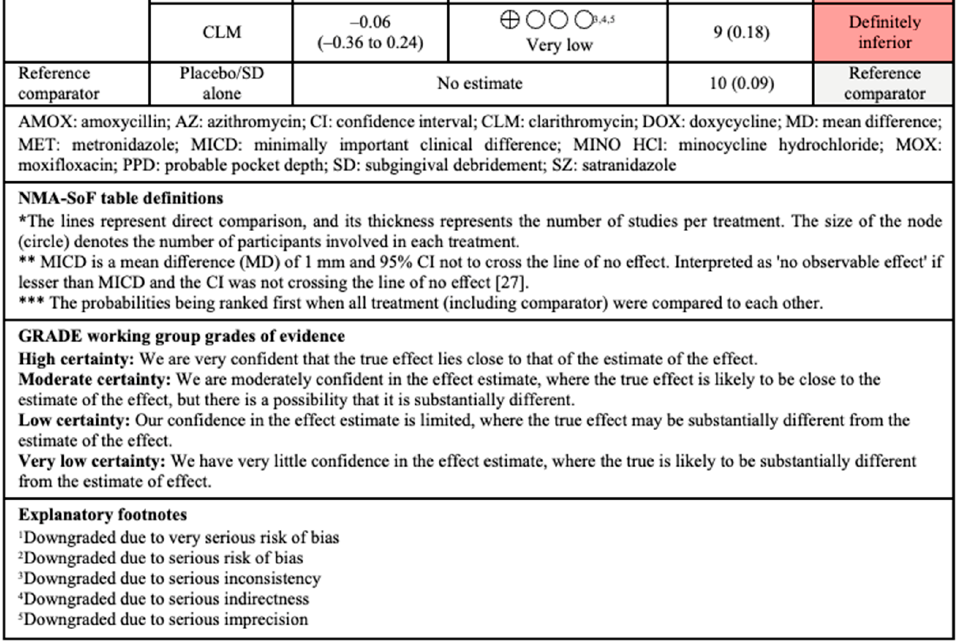
Figure 10. Summary of findings for intermediate-term PPD reduction following the use of systemic antibiotics adjunctive to subgingival debridement.